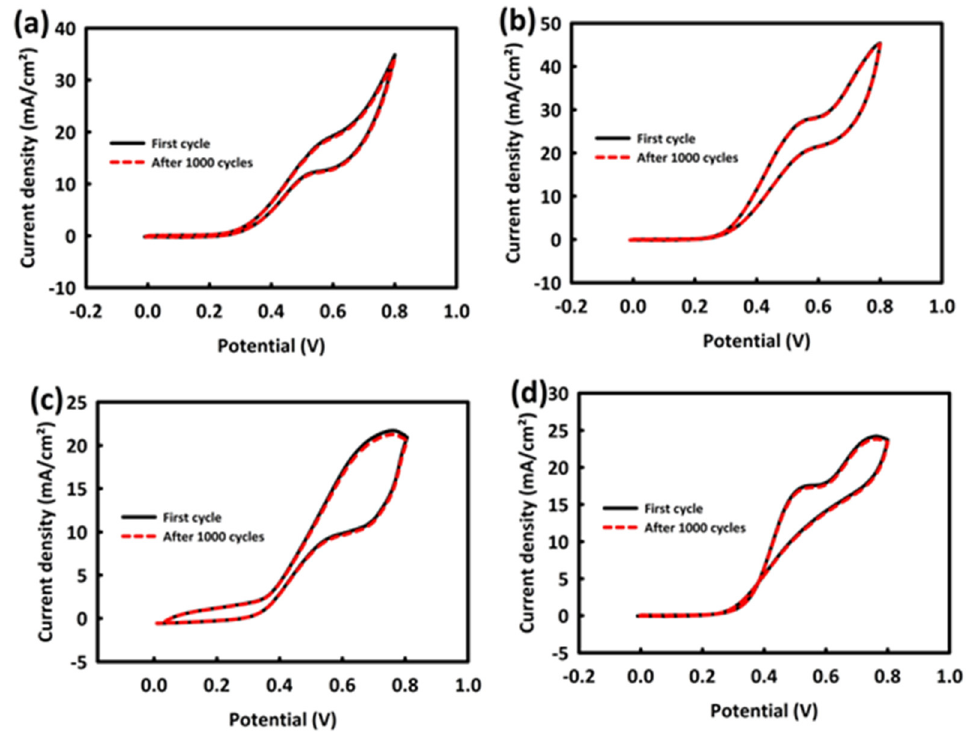
Figure 6. Cyclic stability for ZrO 2 /NiO ( a ) and ZrO 2 /NiO/rGO ( b ) in MOR and cyclic stability for ZrO 2 /NiO ( c ) and ZrO 2 /NiO/rGO ( d ) in EOR.